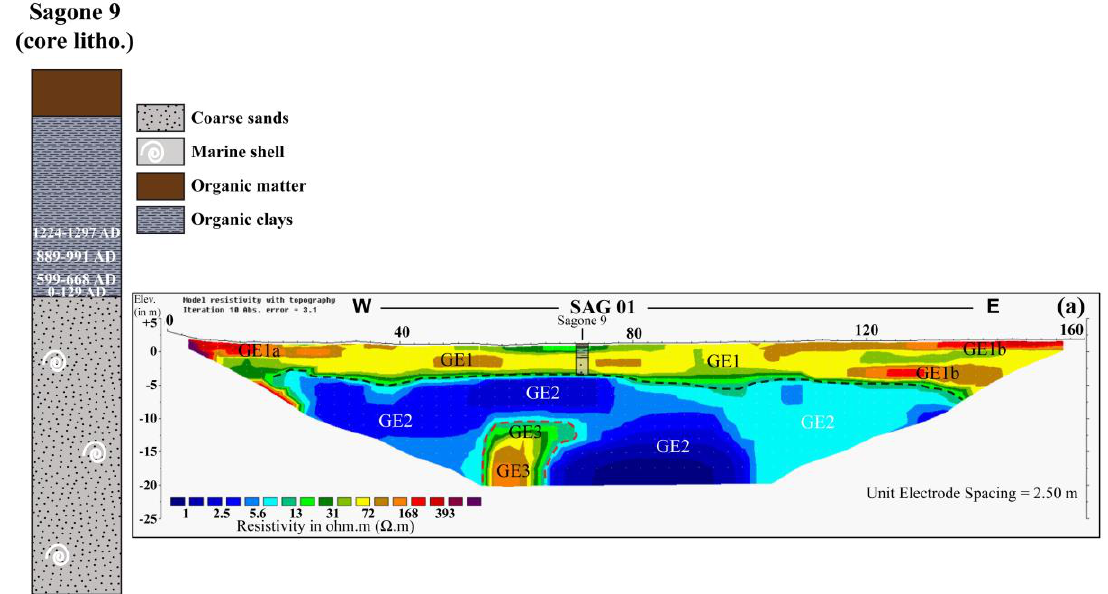
Figure 3. Core lithology and Electric Resistivity Tomography profile (a). The investigation depth is about 20 m, and the core Sagone 9 is situated in the middle part of the profile, enabling us to relate the electrical signal to the granulometry. A first geoelectric unit (GE1, Figure 3a), which is found between the surface and ca. 2.5 m below mean sea level (bmsl), exhibits generally intermediate resistivity values (20–200 Ω m). The stratigraphy of core Sagone 9 indicates the presence of marine coarse sands from ca. 1 to 3 m below sea level (from 2 to ca. 4 m below the surface). Superficial high resistivities (>400 Ω m) at the western edge (GE1a, Figure 3a) are attributable to the granitic bedrock associated with coarse-grained material (footslope deposits). The easternmost part of the first geoelectric unit (GE1b, Figure 3a) reveals an increase of the signal (locally >200 Ω ·m) in two horizontal layers: the first at the surface and the second at ca. 3 m bmsl. The second geoelectric unit (GE2, Figure 3a) shows very low values (<10 Ω ·m) and is found below unit GE1, around 5 m in depth. It consists of sands, and it is noteworthy that the top of Unit GE2 corresponds to the upper limit of the aquifer, which contains haline particles. The third geoelectric unit (GE3, Figure 3a) is at a depth of 12 m below the surface (10 m below present-day sea level), just west of the midpoint of the SAG01 ERT profile and could be interpreted as a part of the granitic bedrock.